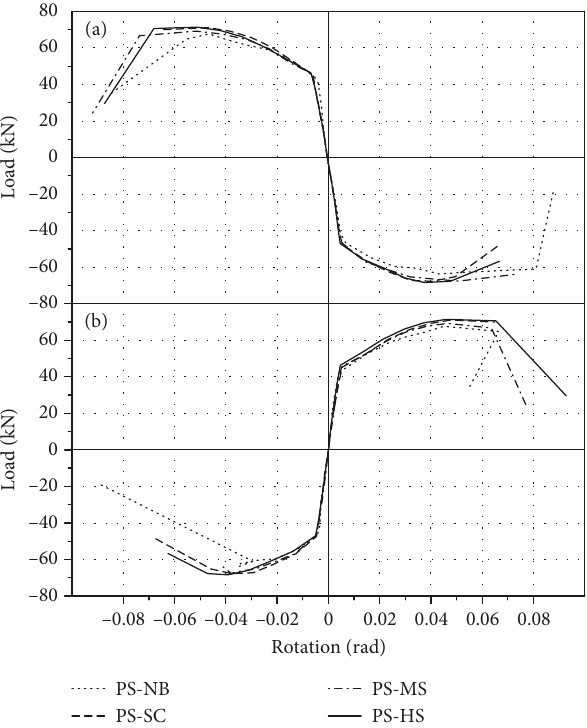
). (b) Left plastic hinge rotation ( θ R